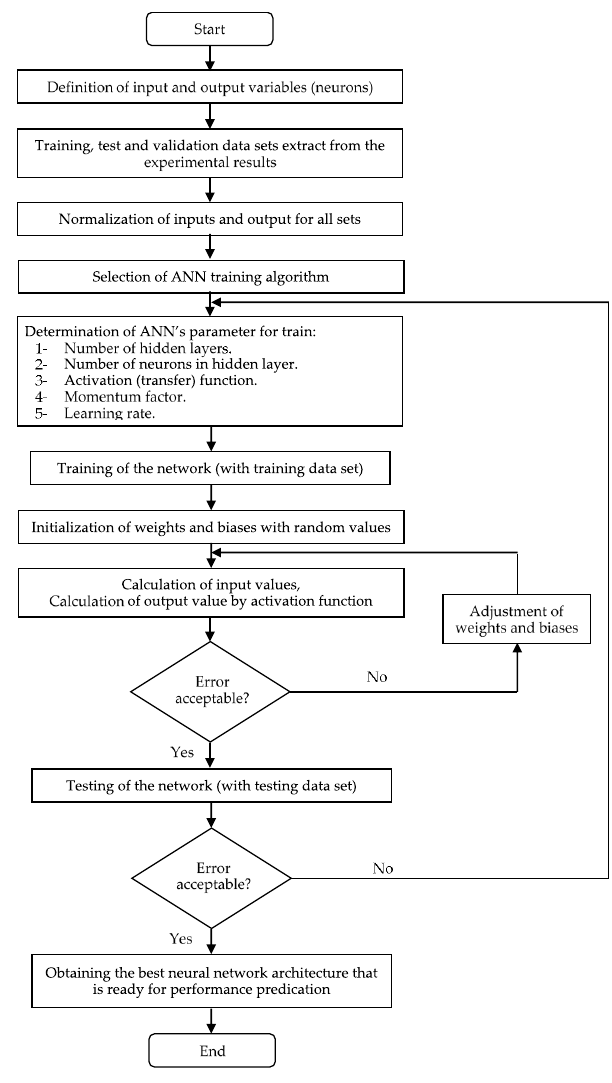
Figure 1. Flowchart for ANN Modeling.